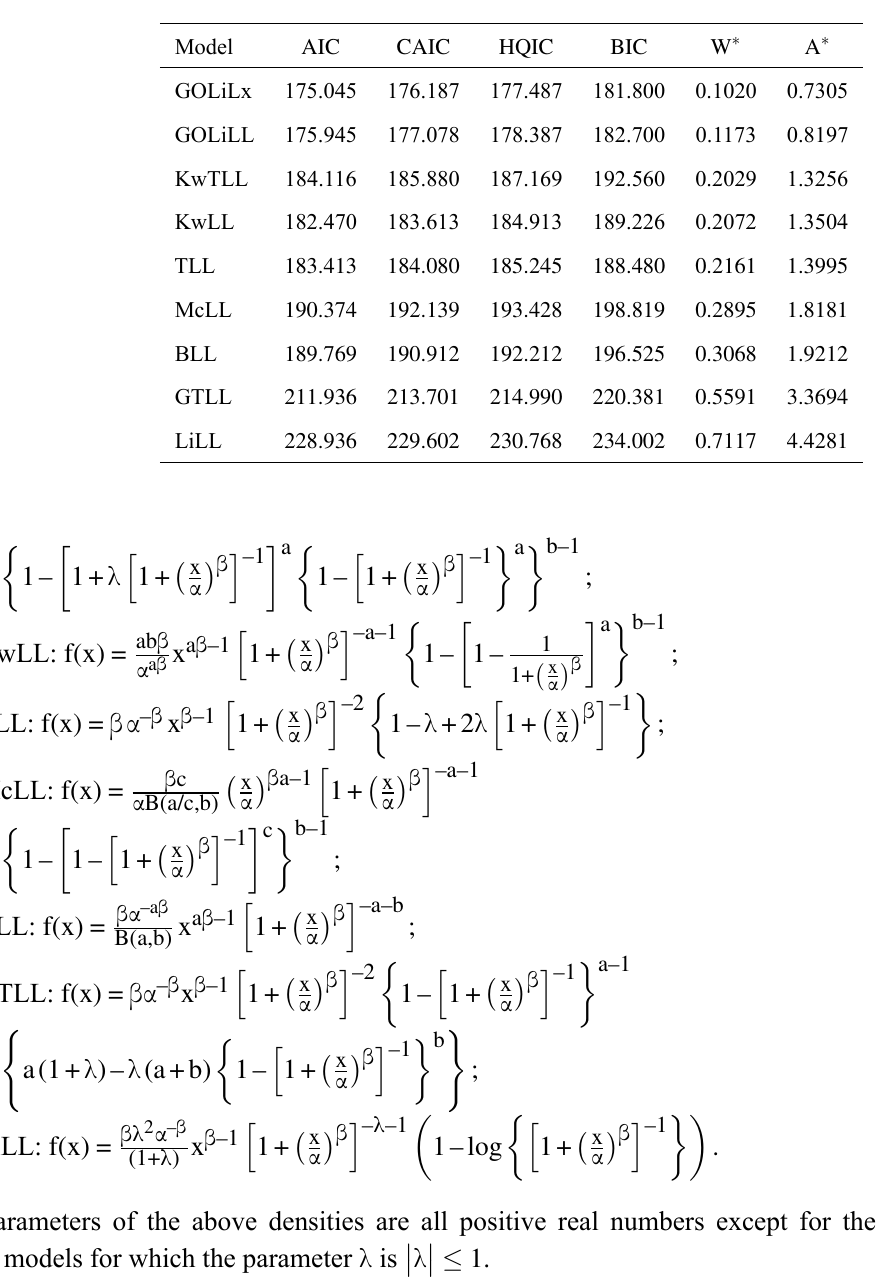
Goodness-of-fit statistics for time-to-failure